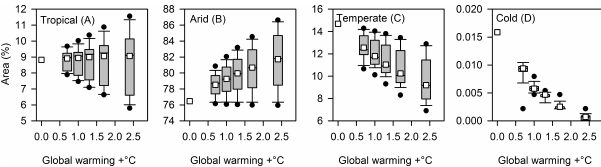
Fig. 3. Boxplots of the proportion of Australia covered by the top level K¨oppen-Geiger climate types under a future climate derived from 17 GCMs. The grey box represents the interquartile range, the line in the box is the median, the whiskers contain 95% of the data and the black circles are outliers. The white squares represent the mode as shown in Fig. 4. The baseline historical climate is repre- sented in this figure by a global warming of 0 ◦ C.